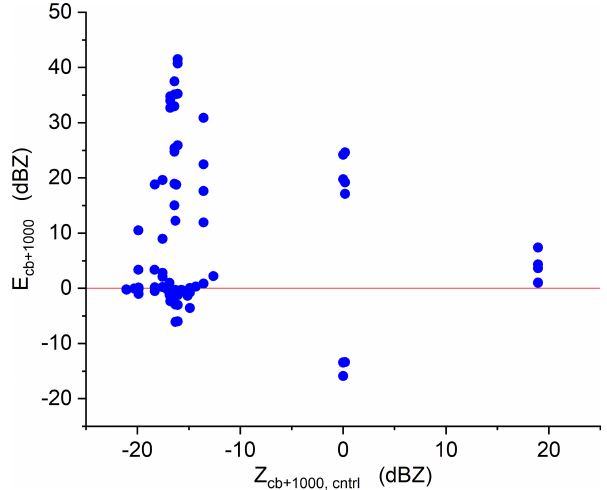
Figure 9. The relation between the seeding efficiency ( E cb + 1000 ) and the reflectivities for the control cases 1km above the cloud base.